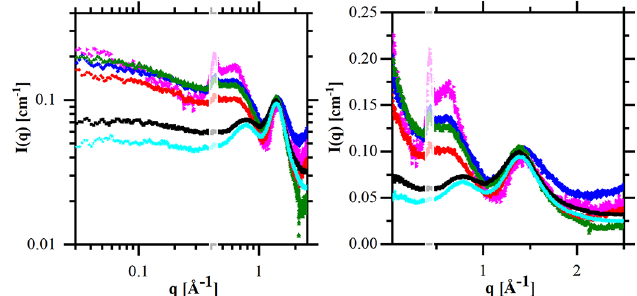
Fig. 10. SAXS spectra of organic phases containing 1.5M DEHiBA dissolved in Isane IP 175 and charged with 0M ■ 0.04 M 0.24M 0.30M 0.37 M 0.61M uranyl by contact with aqueous phases. Left: logarithmic scale; right: linear hump maximum is found at q * = 0.64 A (cid:3) (cid:1) 1 (2 p / q * =